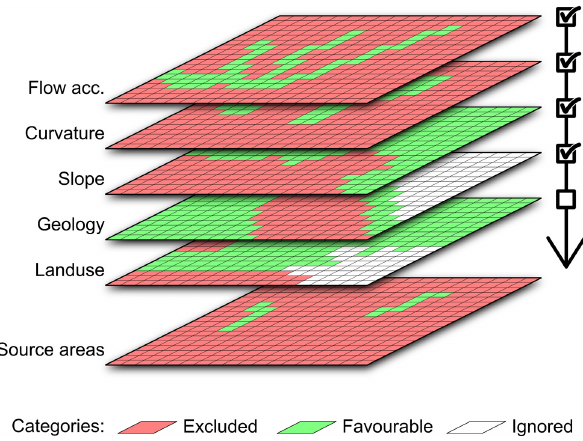
Fig. 2. Illustration of the combination of various datasets for the assessment of the source areas.